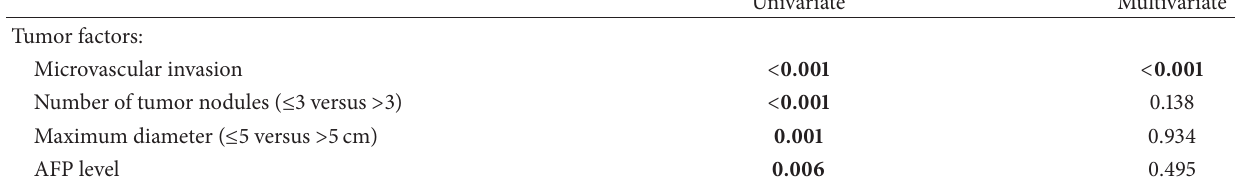
Table 2: Univariate and multivariate 𝑝 values of tumor and nontumor related risk factors for HCC recurrence after LT. The nontumor related risk factors were analyzed stratified for the most dominant tumor related risk factor (microvascular invasion). Univariate